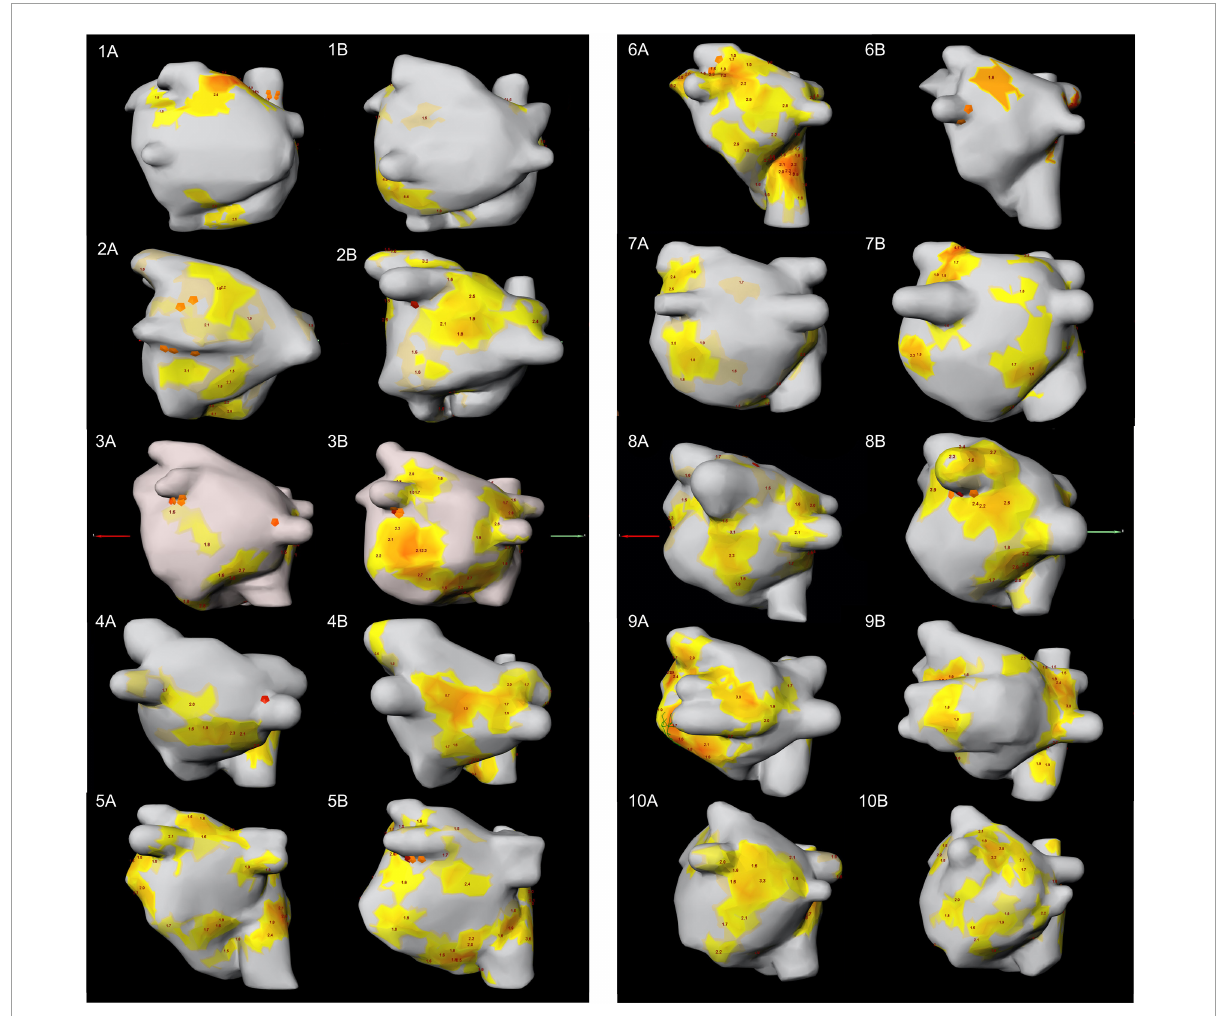
FIGURE4 PA-view showing the distribution of focal and rotor activity of all 10 patients in both mappings. The number indicates the patient number; letter (A) indicates the first mapping, letter (B) indicates the second mapping. PA, posterior